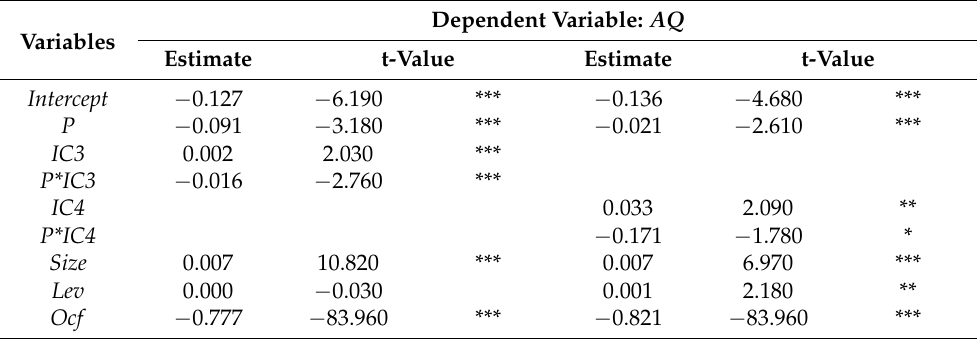
Table 8. Relationship between partner’s audit hour ratio and audit quality depending on internal control system. Average working experience of IC personnel in accounting and IT